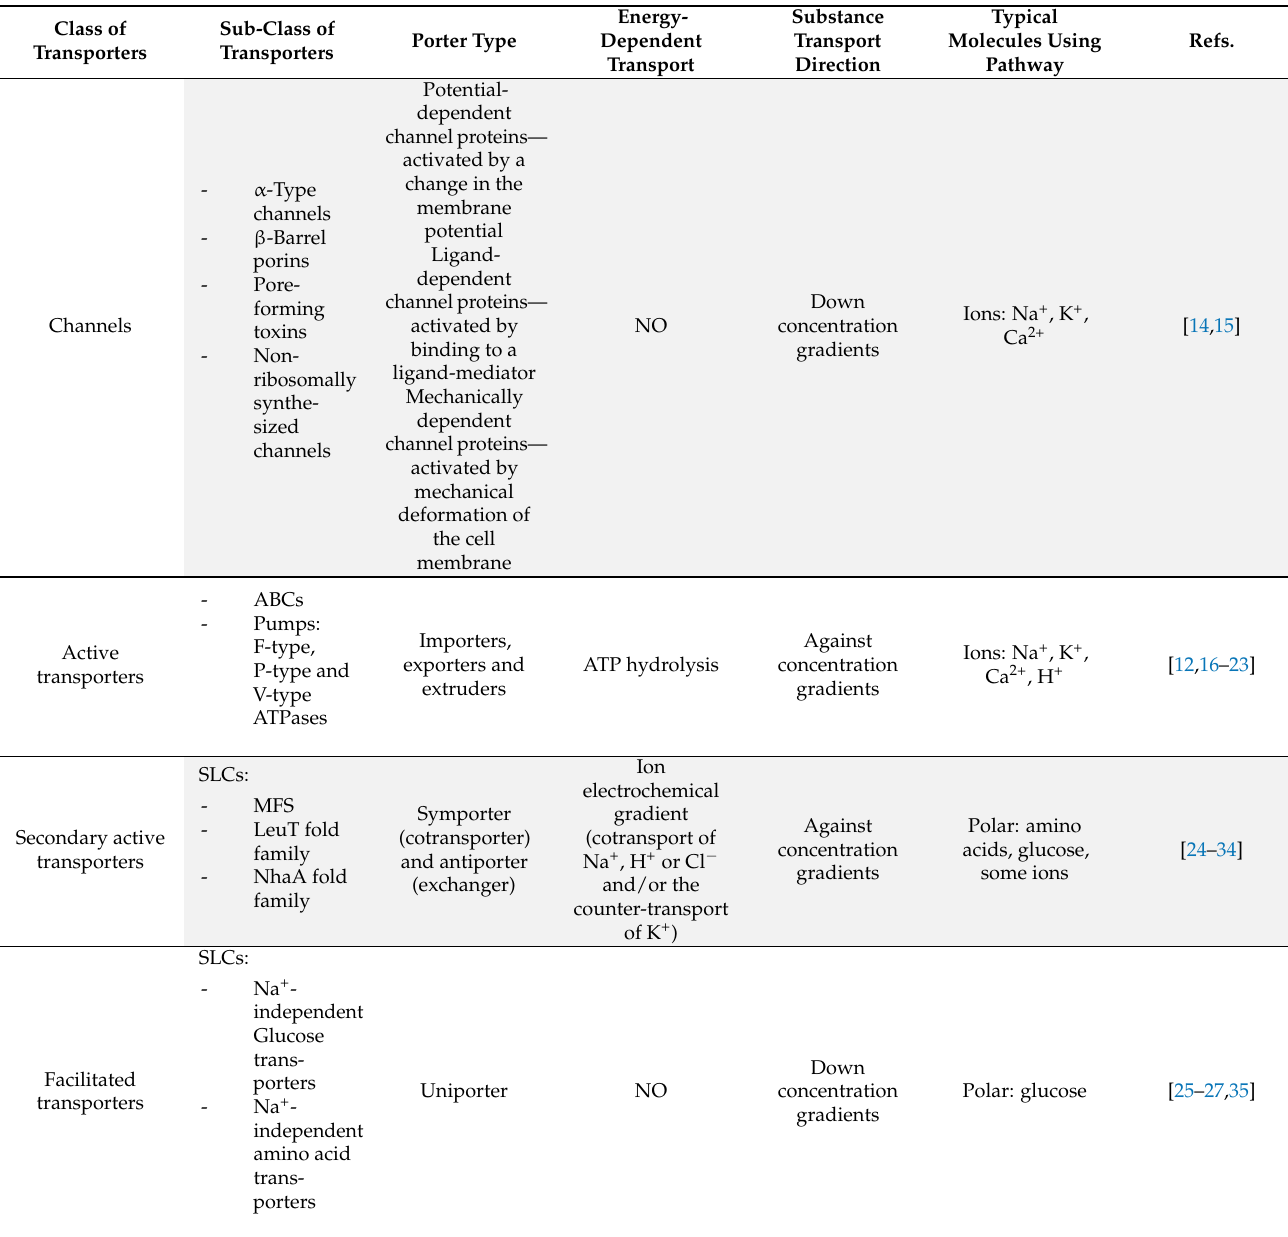
Table 1. Schematic overview of